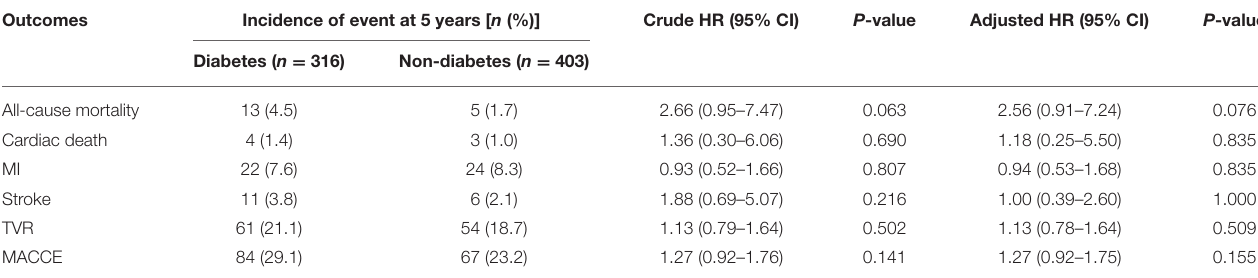
TABLE 4 | Risk of various clinical outcomes up to 5 years in propensity-matched patients.